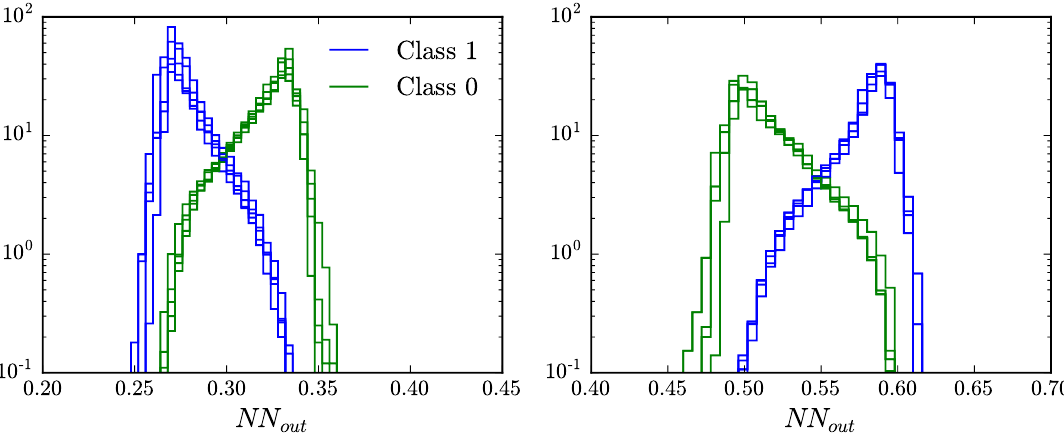
Figure 7 . Outputs of the weakly supervised neural network. The blue lines show distribution of signal for 10 separate trainings, while the green lines show the background. The left and right panels represent when the data set which is has a truth value ratio of 0.7 is labeled as either 0.2 or 0.7, respectively. As pointed out in [27], the possibility of class-(cid:13)ipping exists for weakly supervised networks. To get the signal events in the left panel, the cut on the network output is an upper bound, while in the right panel it is a lower